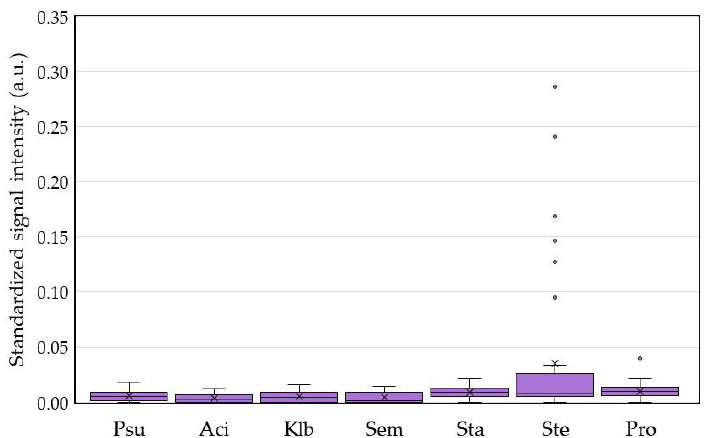
Figure 5. Assessment of target microorganisms in the core ocular surface microbiota dot hybridization model for the patients preparing for cataract surgery. Dots Sta, Ste, and Pro had significantly higher signal intensities than the remaining dots. Dot Ste had a significantly higher signal intensity than dots Sta and Pro. There was no significant signal difference between dots Sta and Pro. Also, there was no significant difference in the signal intensity between any two dots Psu, Aci, Klb, and Sem. a.u. = arbitrary unit.